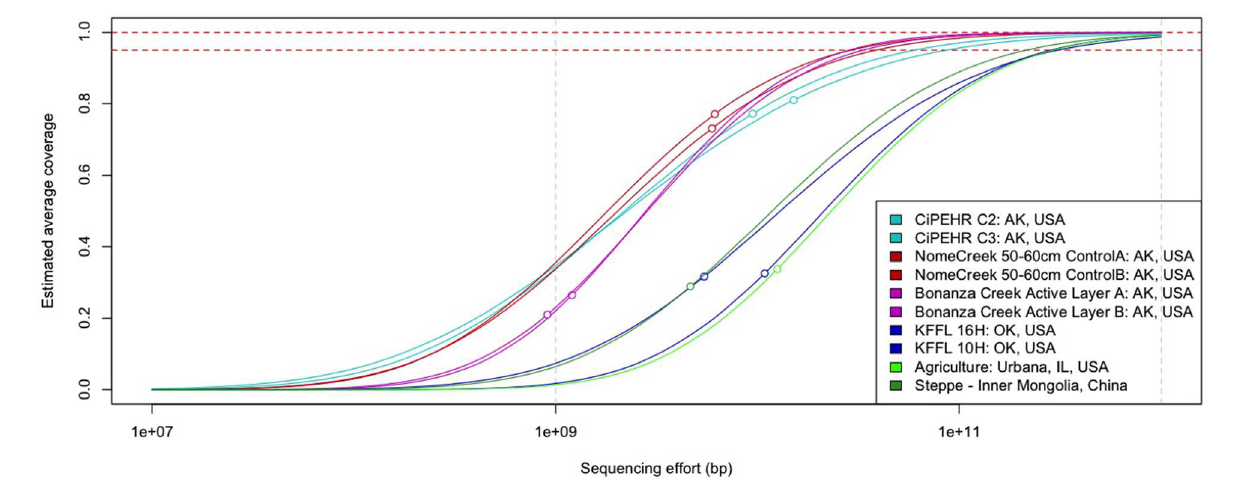
FIGURE 1 | Curves representing soil microbial community complexity estimations as determined by Nonpareil. Nonpareil is a statistical tool that uses read redundancy to estimate dataset complexity and the amount of sequencing effort needed to achieve a desired level of coverage. Circles on curves represent the coverage of the actual sequencing depth for each dataset in relation to the entire curve (projection for complete coverage after the circle). Curves positioned on the right represent more sequence diverse metagenomes than curves positioned on the left.